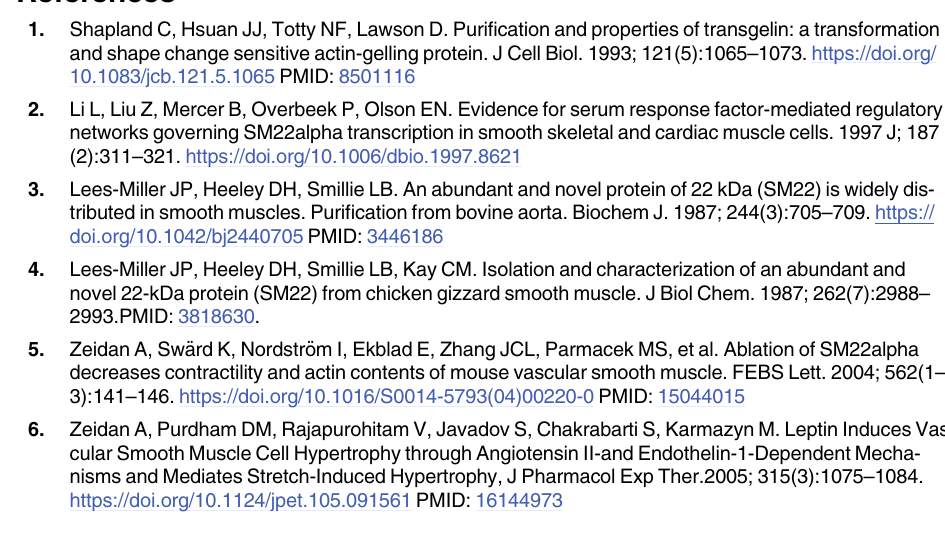
Western blot (IB). Input lanes correspond to the original heart extracts used for the co-IP assays. IgG was used as negative